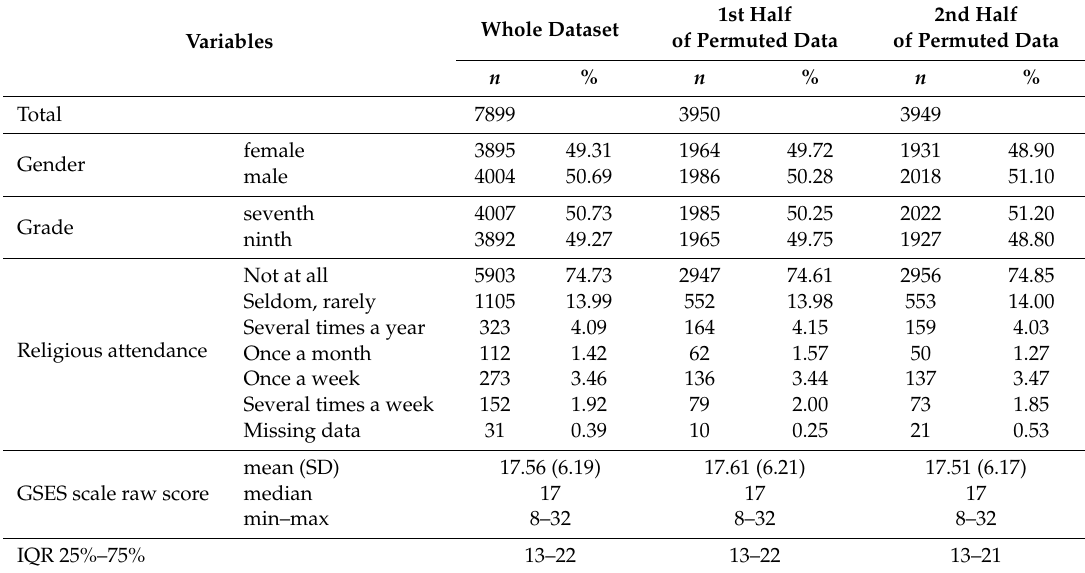
Table 2. Descriptive characteristics of the three datasets used for the analyses. The two smaller datasets were created from the whole set of data by a random permutation of the respondents’ order and then dividing the permuted dataset into two halves.